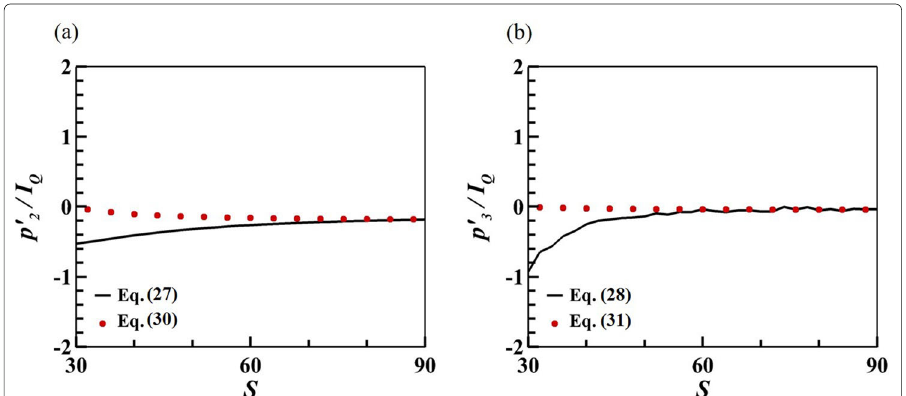
Fig. 5 Sound pressures correspond to ( a ) the second term and ( b ) the third term at different observer distances S . The sound pressures corresponding to the second term are computed by using the Eqs. (27) and (30), respectively. The sound pressures corresponding to the third term are computed by using the Eqs. (28) and (31), respectively. The sound pressures at the non-time dimensional time t = 120 are plotted. The convecting Mach number of the vortex is M a = 0.3 and the observers are distributed along the line with θ = 0 ◦